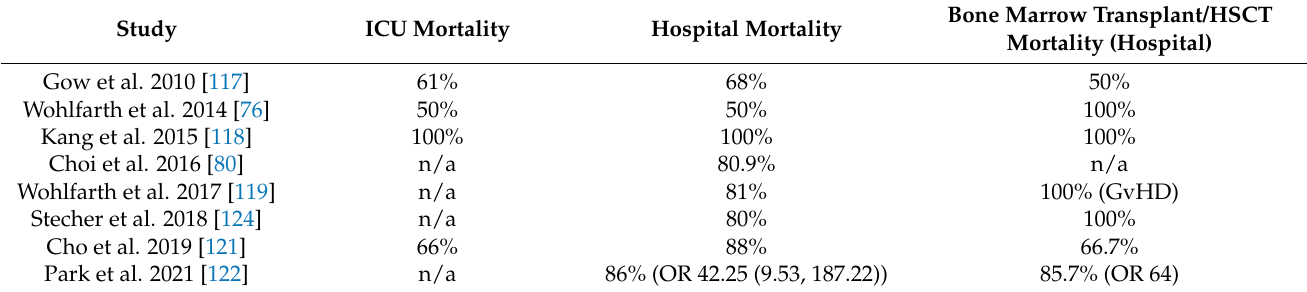
Table 6. Evidence for the use of vvECMO in hematologic malignancies and the respective outcome. Study ICU Mortality Hospital Mortality